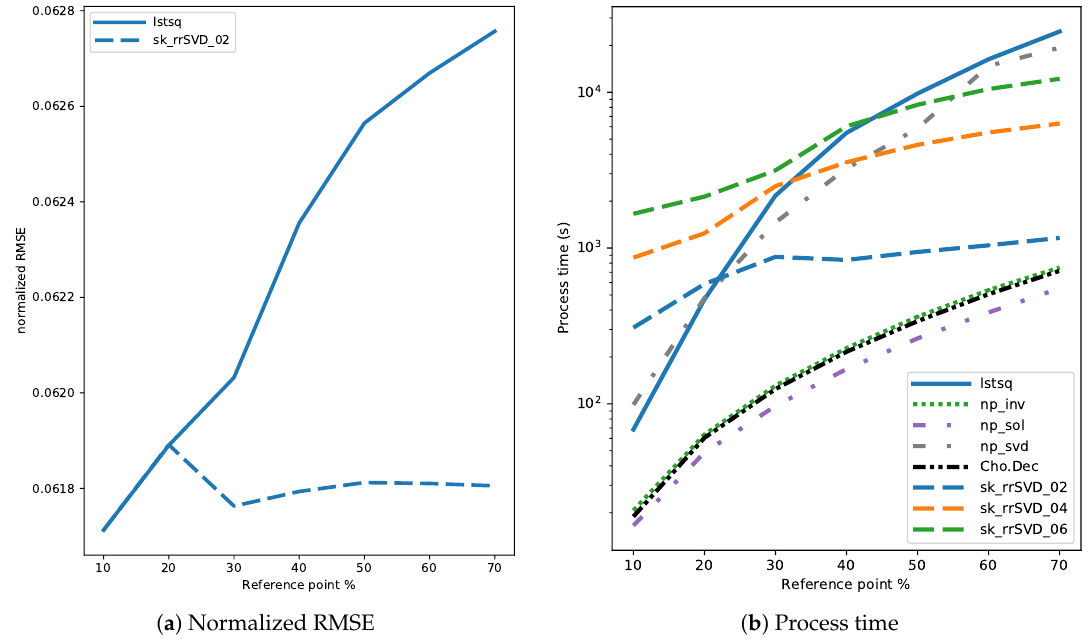
Figure 4. Normalized RMSE values ( a ) and process time in seconds taken to compute Equation (1) ( b ) as a function of reference point percentage for the Census dataset. In ( a ), only methods that at any reference point percentage differ from Lstsq with Kruskal–Wallis H test are shown along Lstsq